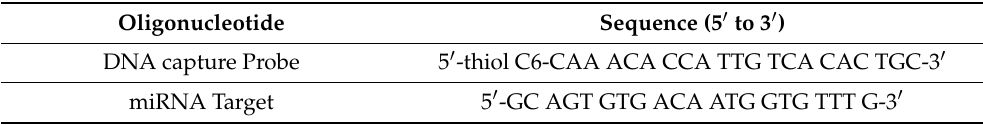
Table 1. DNA probes and DNA targets base sequencing mimicking the miRNA 122. Oligonucleotide Sequence (5 (cid:48) to 3 (cid:48)